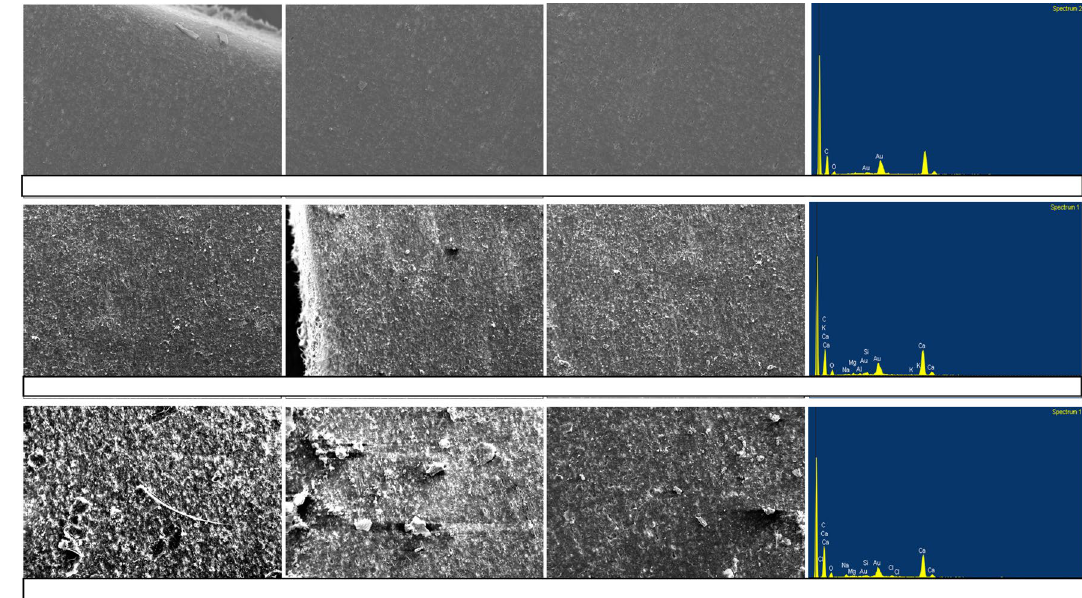
Figure 11. SEM–EDX for a pristine MTI lateral (top row), SEM–EDX for adhered sediment (ABF) from AF effluent (second row), and SEM–EDX for AS from HFCW effluent (bottom